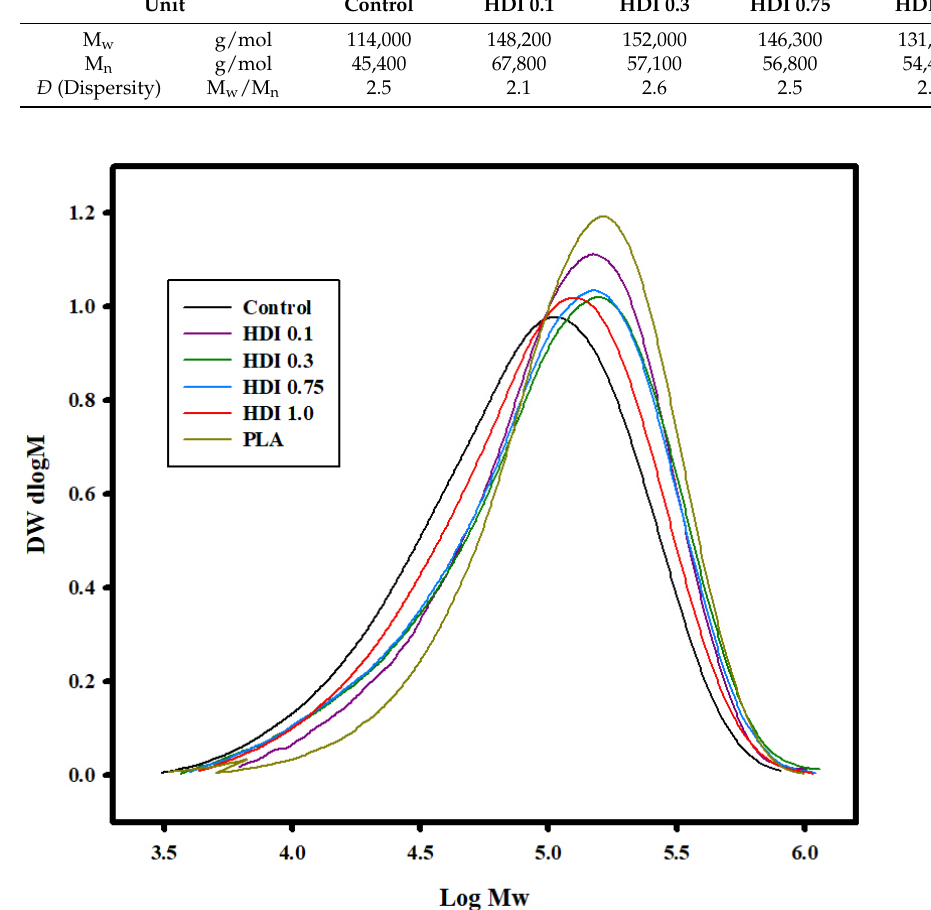
Figure 3. GPC curves of control and blend specimens prepared with various HDI contents.